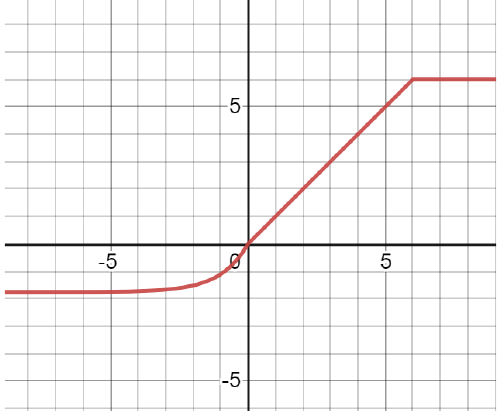
Figure 6. R6-SELU activation function image.